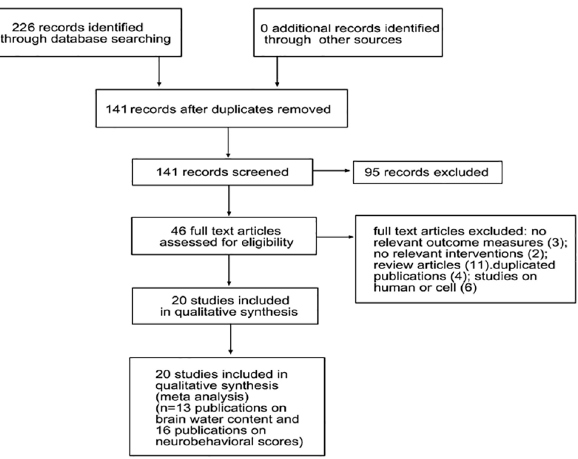
Fig 1. Progression from literature search to meta-analysis. The number of exclusions from the initial literature search is shown.